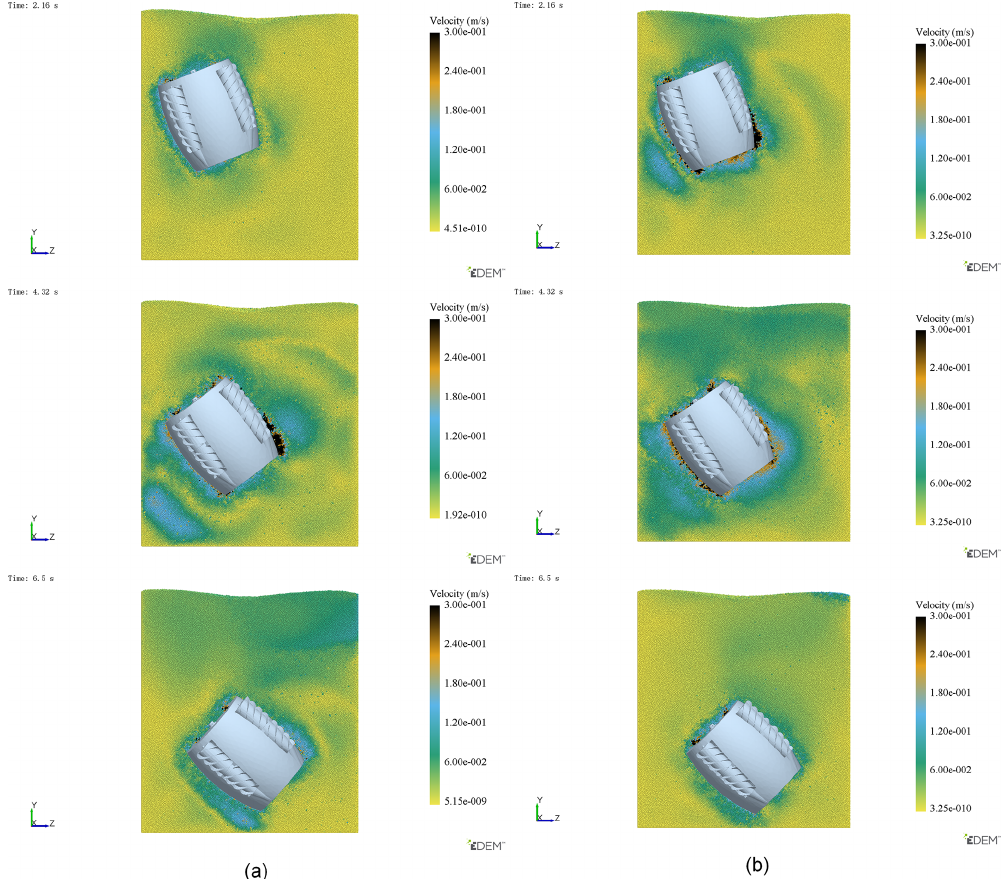
Figure 24. Simulation of the screw speed ratio of 4:1 (a) and screw speed ratio of 2:1 (b) , when t = 2 . 16s, t = 4 . 32s, and t = 6 . 5s.